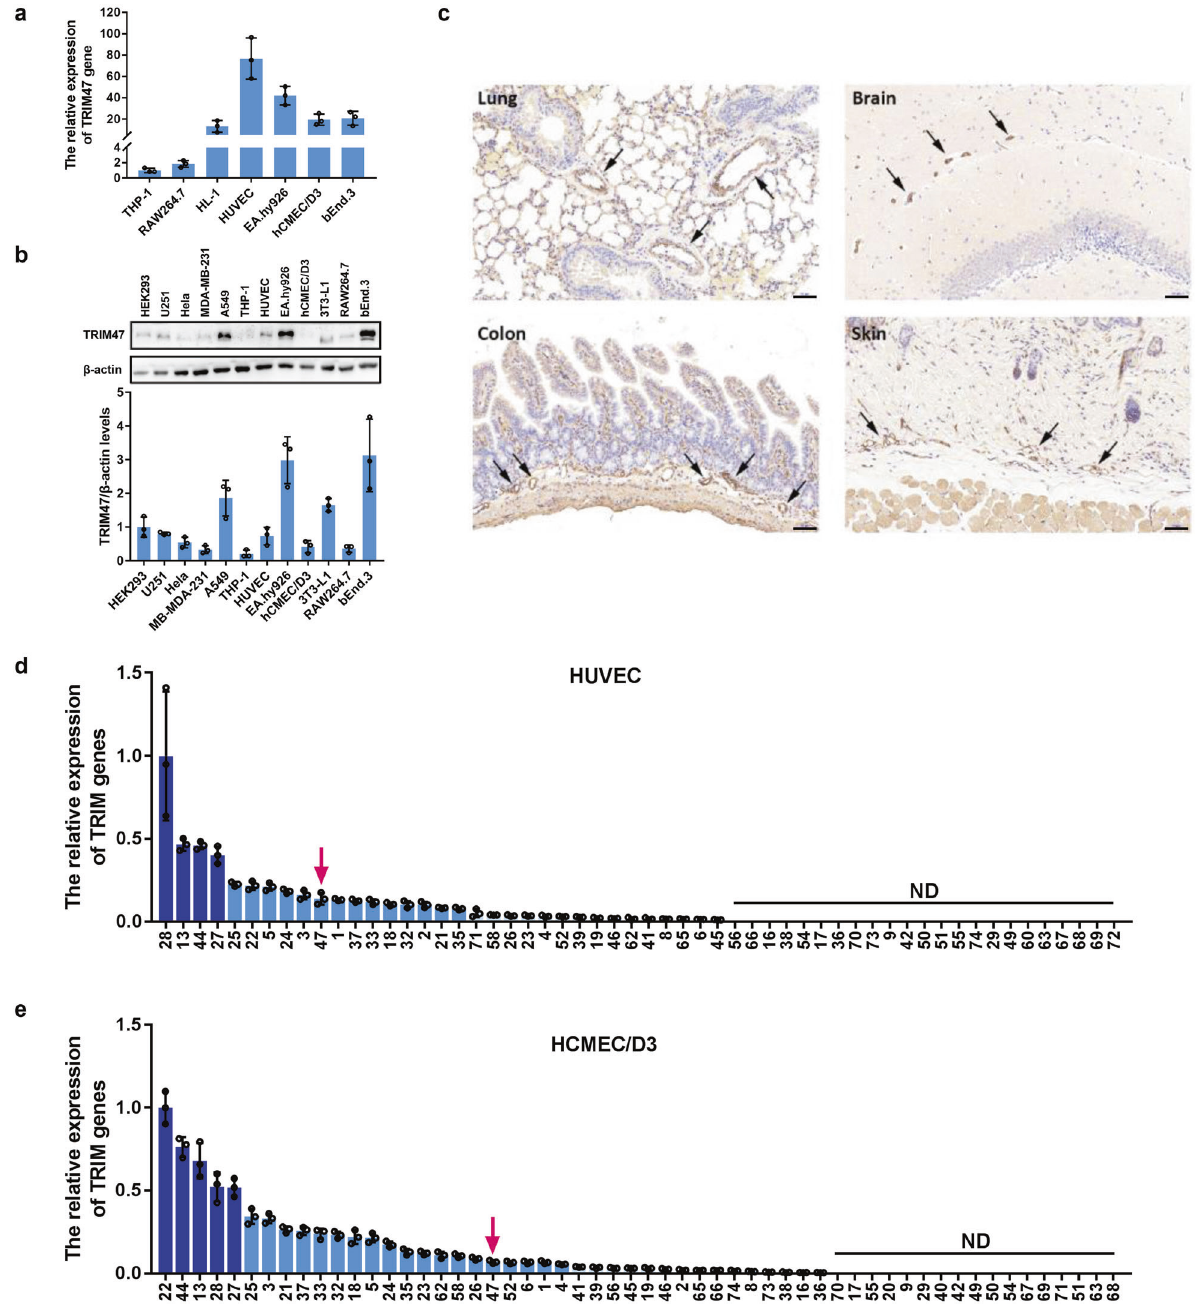
Fig. 2 TRIM47 is highly expressed in vascular endothelial cells. a The relative expression of TRIM47 gene in different cells was detected by real- time PCR ( n = 3). b Representative images of the immunoblots of TIRM47 and β -actin in different cells detected by western blot (up) and the relative quantitation of TIRM47 protein levels (down, n = 3). THP-1, human monocytic cell line, RAW264.7, murine macrophage cell line, HL-1, mouse cardiac muscle cell line, HUVEC, human umbilical vein endothelial cells, EA.hy926, human umbilical vein cell line, hCMEC/D3, human brain microvascular endothelial cell line, bEnd.3, mouse brain microvascular endothelial cell line, HEK293, Human embryonic kidney 293 cells, U251, human glioma cell line, HeLa, human cervical cancer cells, MDA-MB-231, human triple-negative breast cancer cell line, A549, human lung carcinoma cell line, and 3T3-L1, mouse preadipocytes. c Representative immunohistochemical images showing positive staining of TRIM47 in the vascular lining of multiple tissues (partial ampli fi cation from Fig. 1a, n = 3). Scale bar, 50 μ m. The relative expression of 56 TRIM genes in ( d ) HUVECs and ( e ) hCMEC/D3 was detected by real-time PCR. ND: not detected ( n = 3) cytokines (Fig. 5g). In addition, knockdown of TRIM47 remarkably adhesion of THP-1 cells to HUVECs, but overexpression of TRIM47 inhibited cell proliferation and migration induced by TNF α in had the opposite effects (Fig. 5f). TRIM47 knockdown also HUVECs (Supplementary Fig. 3). These results indicated that suppressed TNF α -induced secretion of pro-in fl ammatory cyto- TRIM47 was a positive regulator of TNF α -induced endothelial kines such as IL-1 β and IL-6. By contrast, overexpression of activation. TRIM47 promoted TNF α -induced production of pro-in fl ammatory